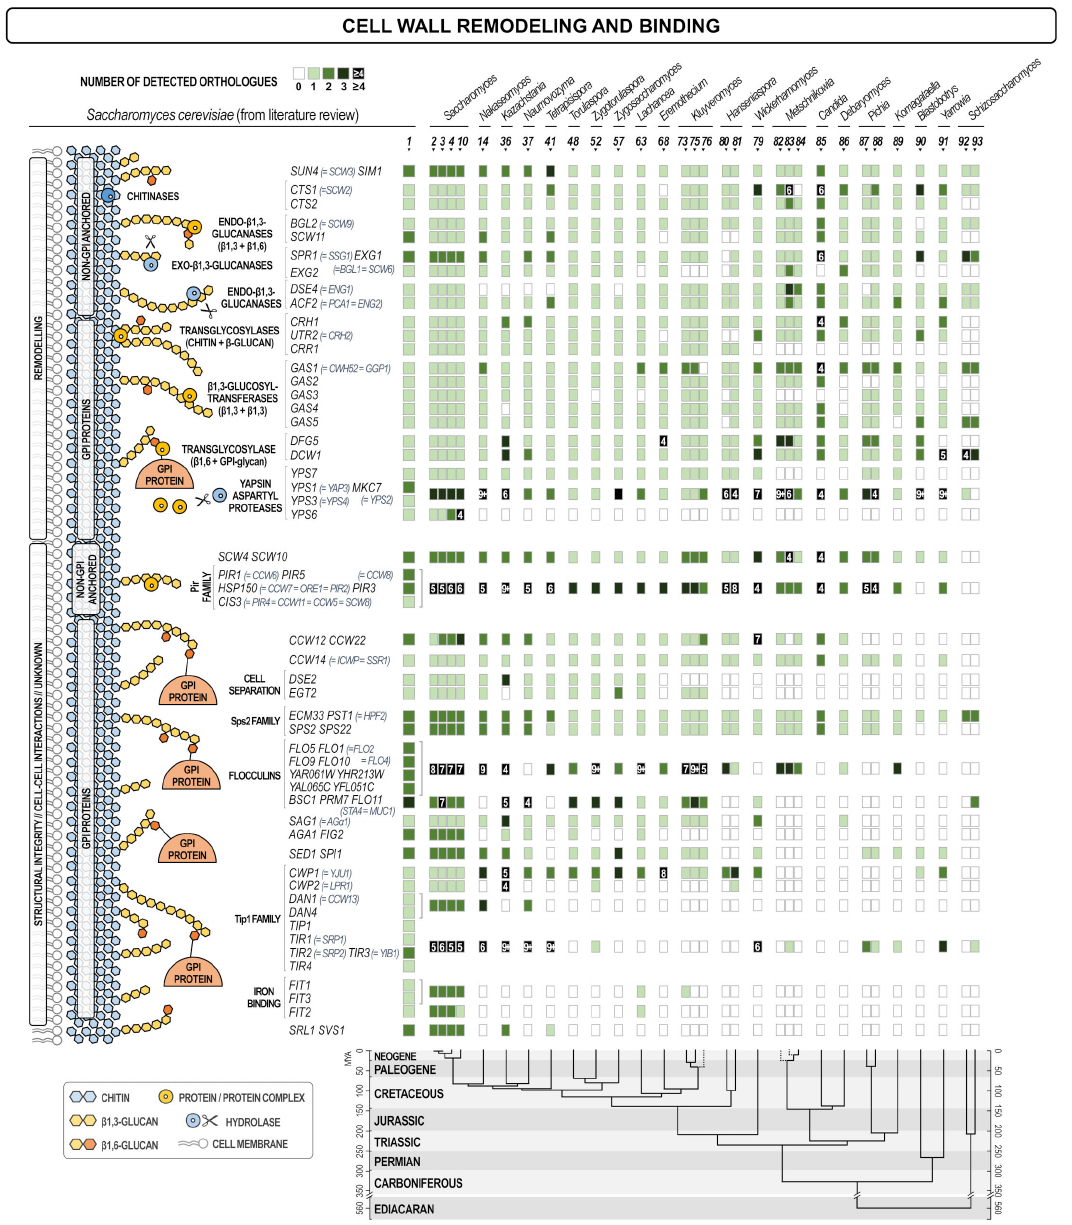
Figure 5. Heat map of orthologues of S. cerevisiae genes coding for proteins that reside in the cell wall of yeasts that are taxonomically more distant from S. cerevisiae . Every gene is presented in one row, while every yeast is presented in one line. The heat map includes representatives of genera presented in Figure 4 for comparison with evolutionary more distant yeasts: 80 Hanseniaspora (H.) uvarum, 81 H. osmophila , 82 Metschnikowia (M.) reukaufii , 83 M. pulcherrima , 84 M. bicuspidata , 85 Candida albicans , 86 Debaryomyces hansenii , 87 Pichia (P.) kudriavzevii , 88 P. membranifaciens , 89 Komagataella pastoris , 90 Blastobotrys adeninivorans , 91 Yarrowia lipolytica , 92 Schizosaccharomyces (Schiz.) japonicus , 93 Schiz. pombe . The scheme of the cellular process with the site in which the product of each gene is involved is shown on the left. The intensity of the color of every square is proportional to the number of orthologues found as depicted in the inset legend. White square means